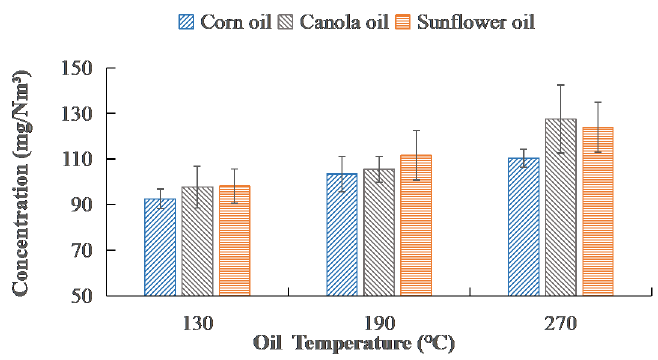
Figure 3. Emission concentrations of three vegetable oils at different temperatures.